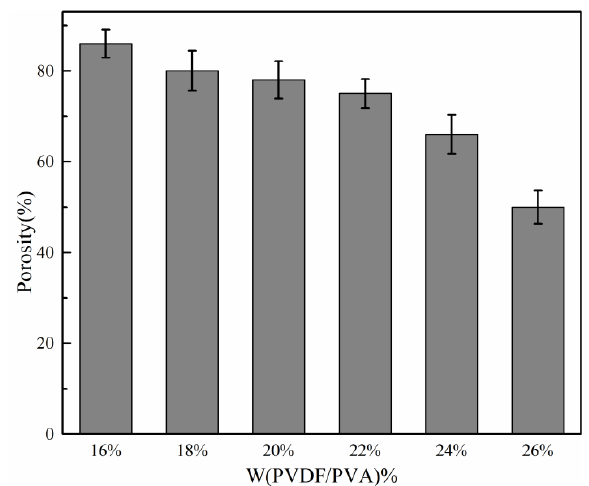
Figure 2. Effect of total polymer concentration on membrane porosity.